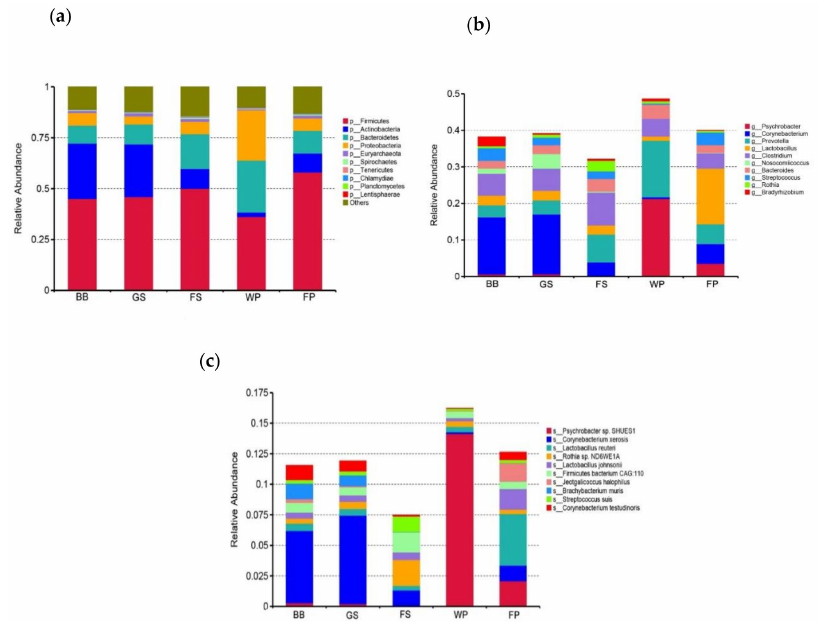
Figure 3. The relative abundances of predominant taxa at the phylum ( a ), genus ( b ), and species ( c ) level, among all samples. BB, GS, FS, WP, and FP refer to the bioaerosols collected from the piggeries that exclusively housed breeding boars, gestating sows, farrowing sows, weaning piglets, and finishing pigs, respectively.